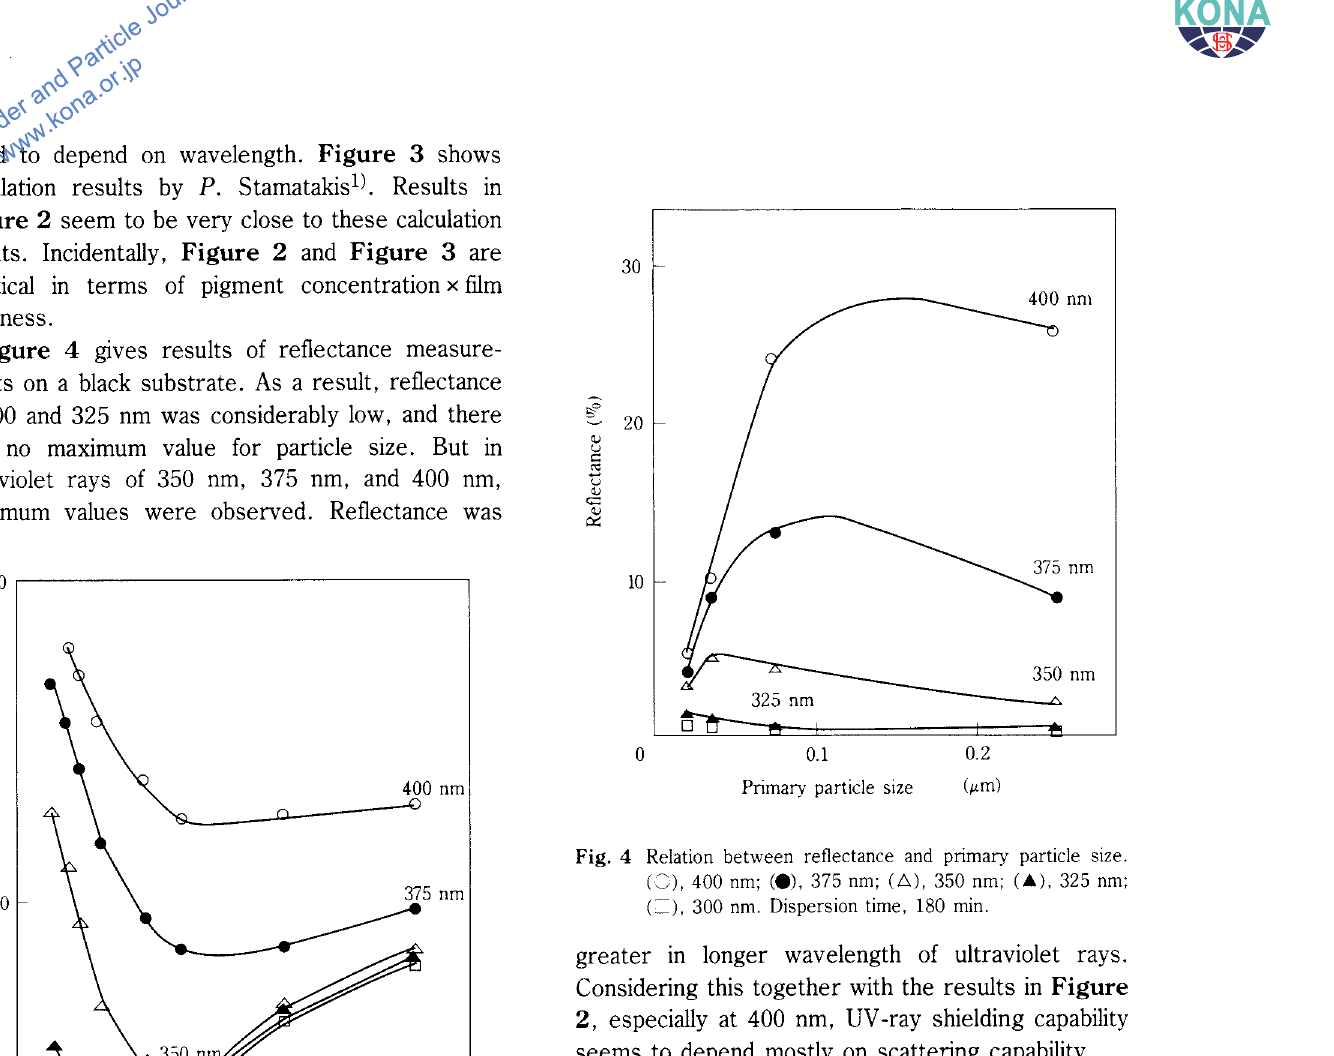
Fig. 4 Relation between reflectance and primary particle size. (:::;), 400 nm; (e), 375 nm; (6), 350 nm; (.6.), 325 nm; (=). 300 nm. Dispersion time, 180 min. greater in longer wavelength of ultraviolet